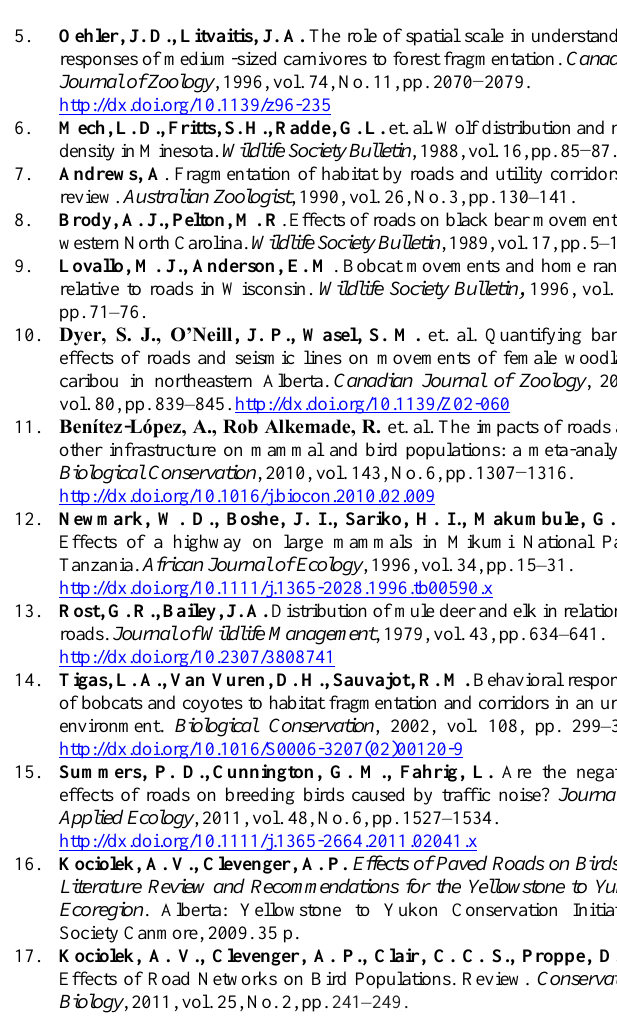
Fig. 4. Number of footprint showed by large and medium size mammals in road and control lines. The boxes represent the inter-quartile range and the median is indicated by the bold horizontal line. The vertical lines at the top of the boxes extend to the largest value within 1.5 times the interquartile range [23]. In this particular, case the vertical lines all reach the maximum value of the variables